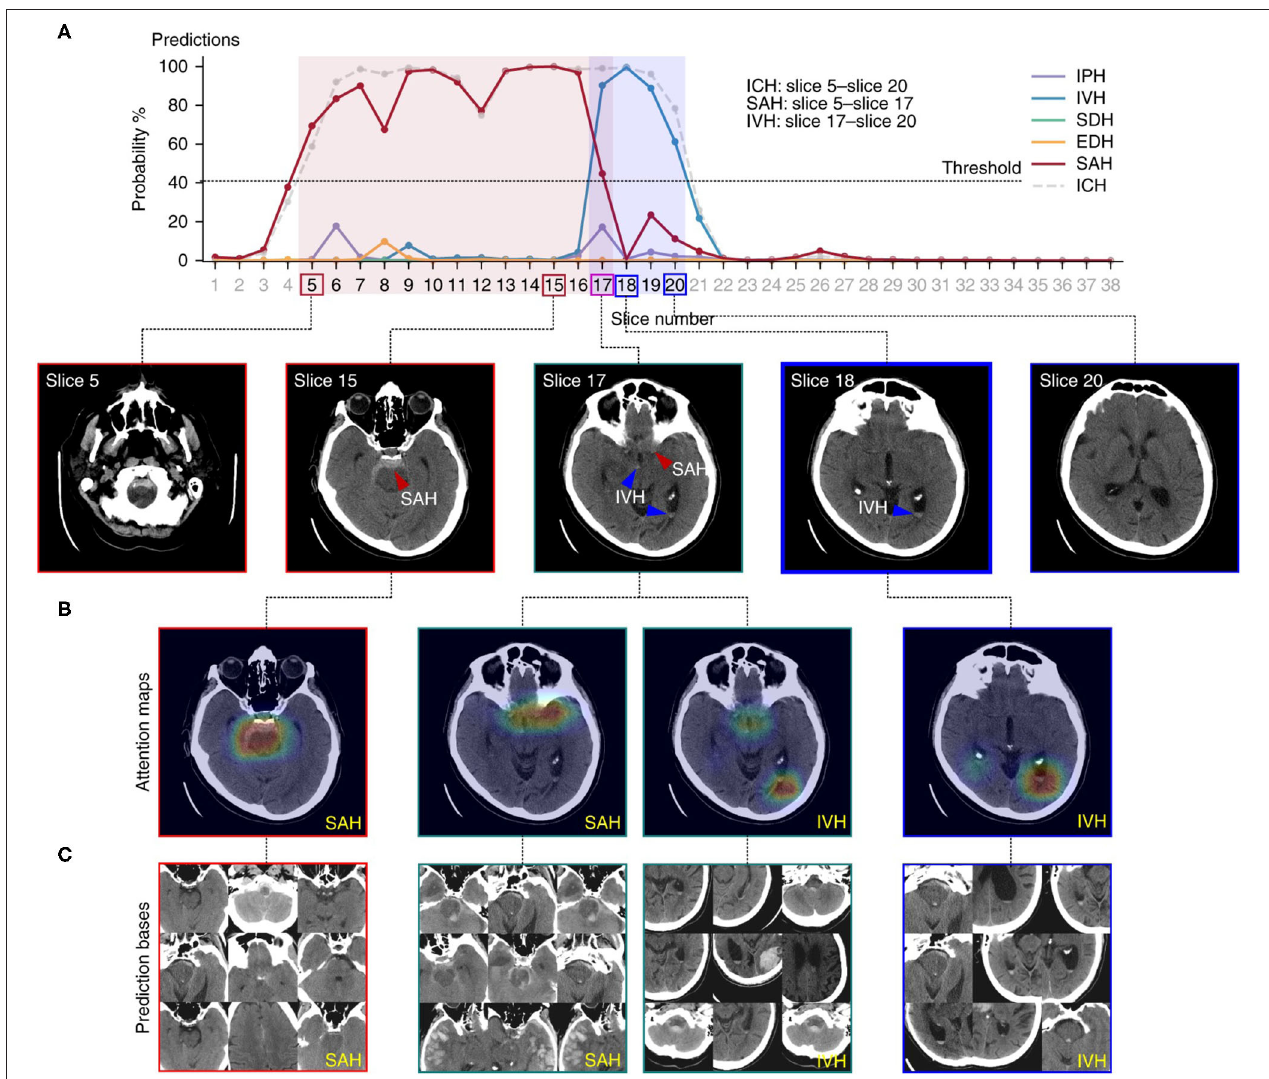
FIGURE 9 | An example of a deep learning algorithm to localize intracranial hemorrhage and predict its subtype (28). Figure depicts the algorithmic output for a single head CT exam. (A) Demonstrates the probability determined by the algorithm for presence of each subtype of intracranial hemorrhage on each image. A 40% probability was designated as the minimum probability threshold to indicate the presence of a hemorrhage subtype on an image. The legend to the right shows the intracranial hemorrhage subtype that corresponds to each color. The boxes around the slice numbers indicate the example slices shown in the row of images below the graph, with the colors of the boxes indicating hemorrhage subtype(s) present on each image. Colored arrows on the images indicate the general prediction location and hemorrhage subtype. In (B) , a probabilistic heatmap is superimposed on the brain to indicate a more specific region of prediction. (C) Displays prediction bases, which are the most relevant training images for specific hemorrhage subtypes. These can be examined by human practitioners to gain insight into the main drivers, or “rationale,” behind the algorithm’s predictions, thereby increasing